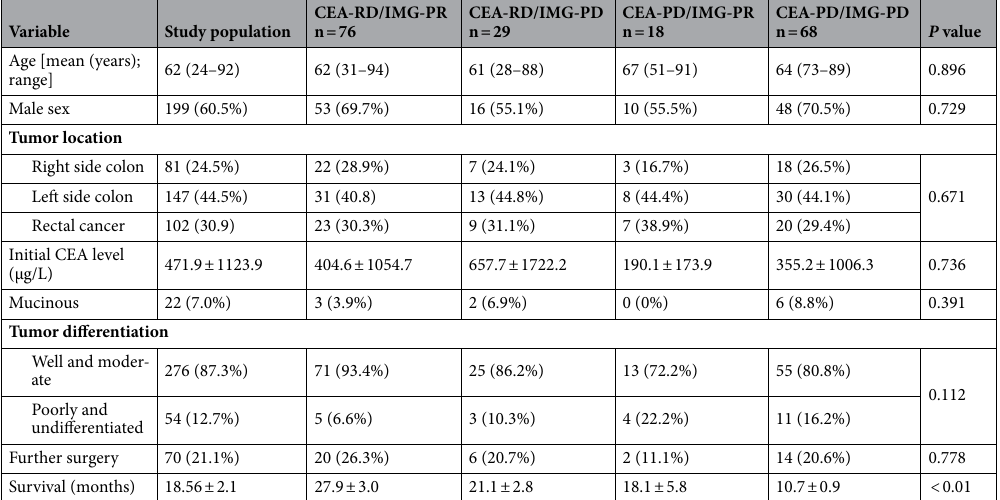
Table 2. The relationship between treatment evaluation by image and CEA with different variables.